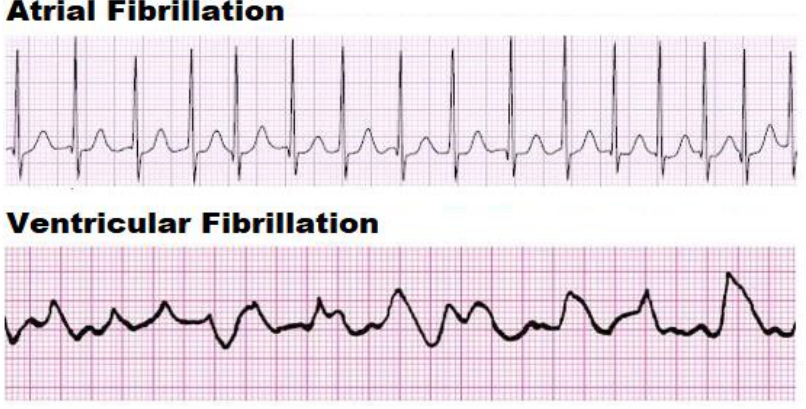
Figure 1. Atrial and Ventricular ECG Signals [31,32].